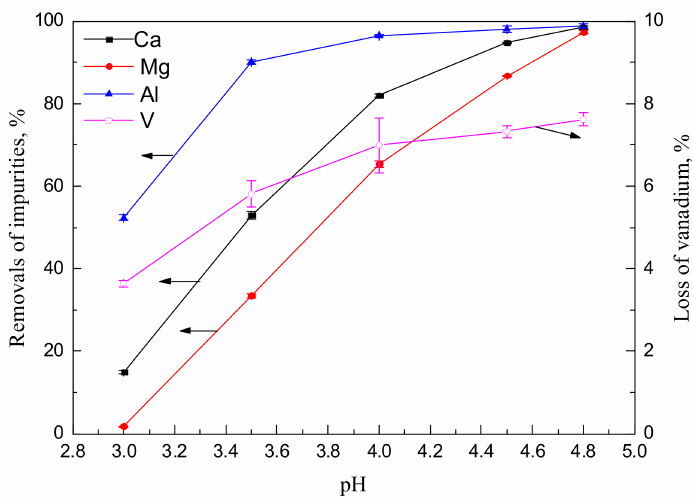
Figure 8. Effect of the pH value on the removals of impurities and the loss of